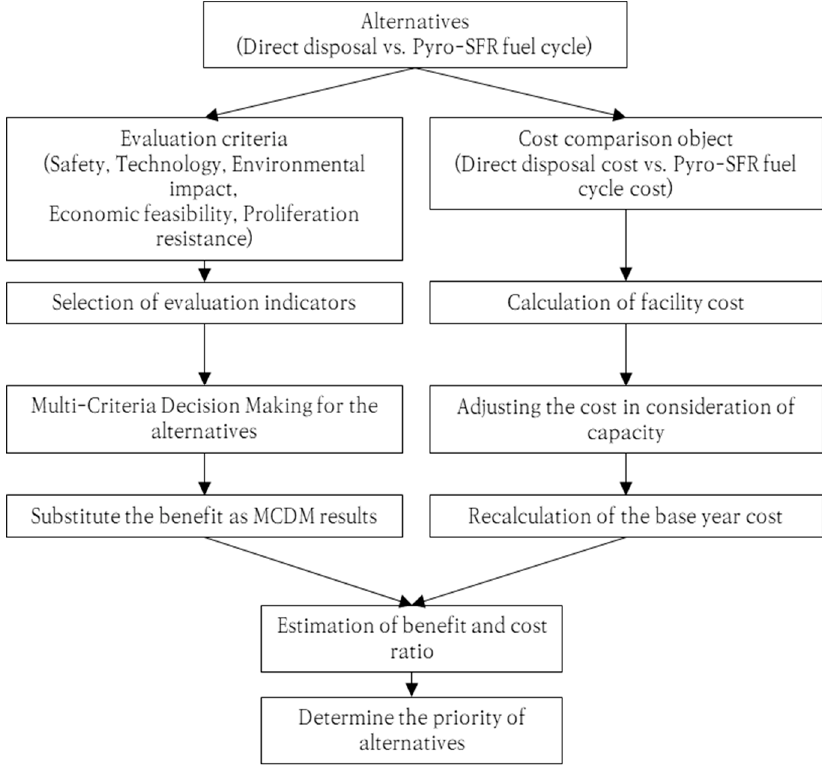
Figure 1. The procedure of benefit and cost ratio analysis.